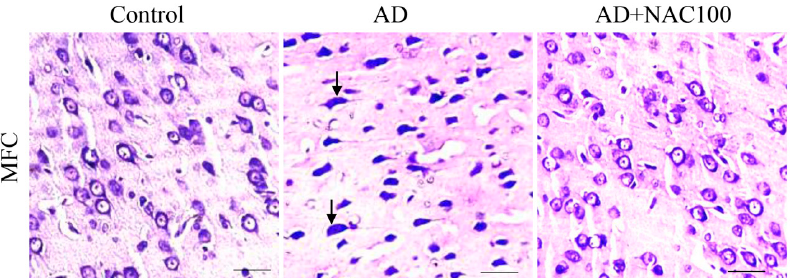
Figure 5. Photomicrographs of the prefrontal cortex in different groups of rats stained with Cresyl violet stain. Note the degenerating neurons (Arrow) in AD group. (Photomicrographs of Sham and AD + NAC 50 groups are avoided for simplicity). Scale bar = 20 µ. MFC—